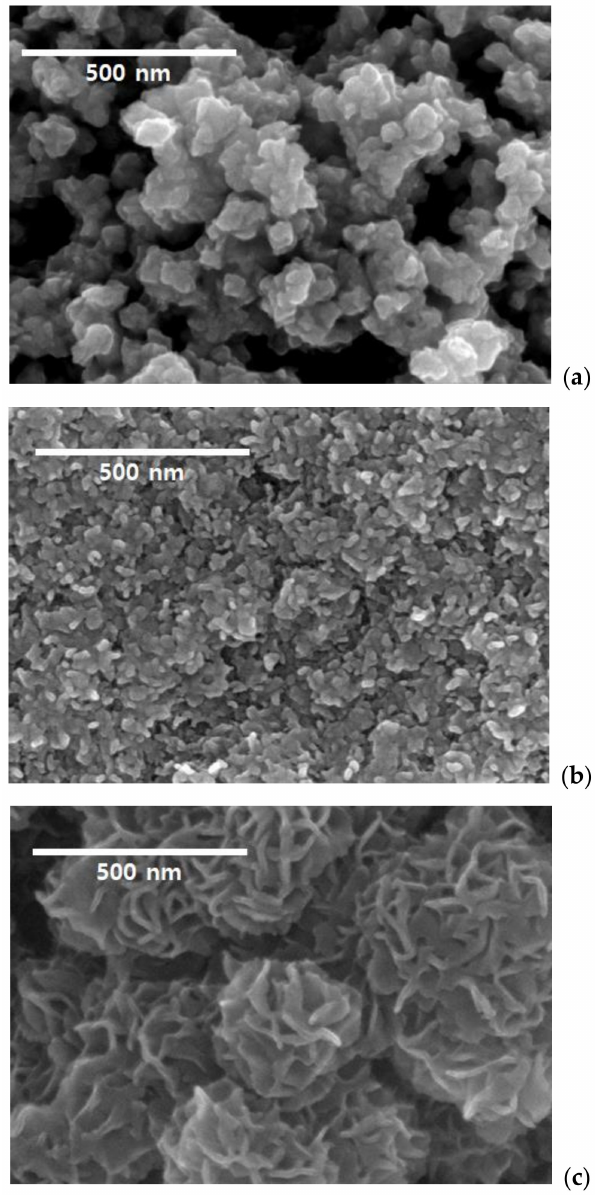
Figure 1. SEM images of MoS 2 prepared at ( a ) pH 4.5; ( b ) pH 7.0; and ( c ) pH